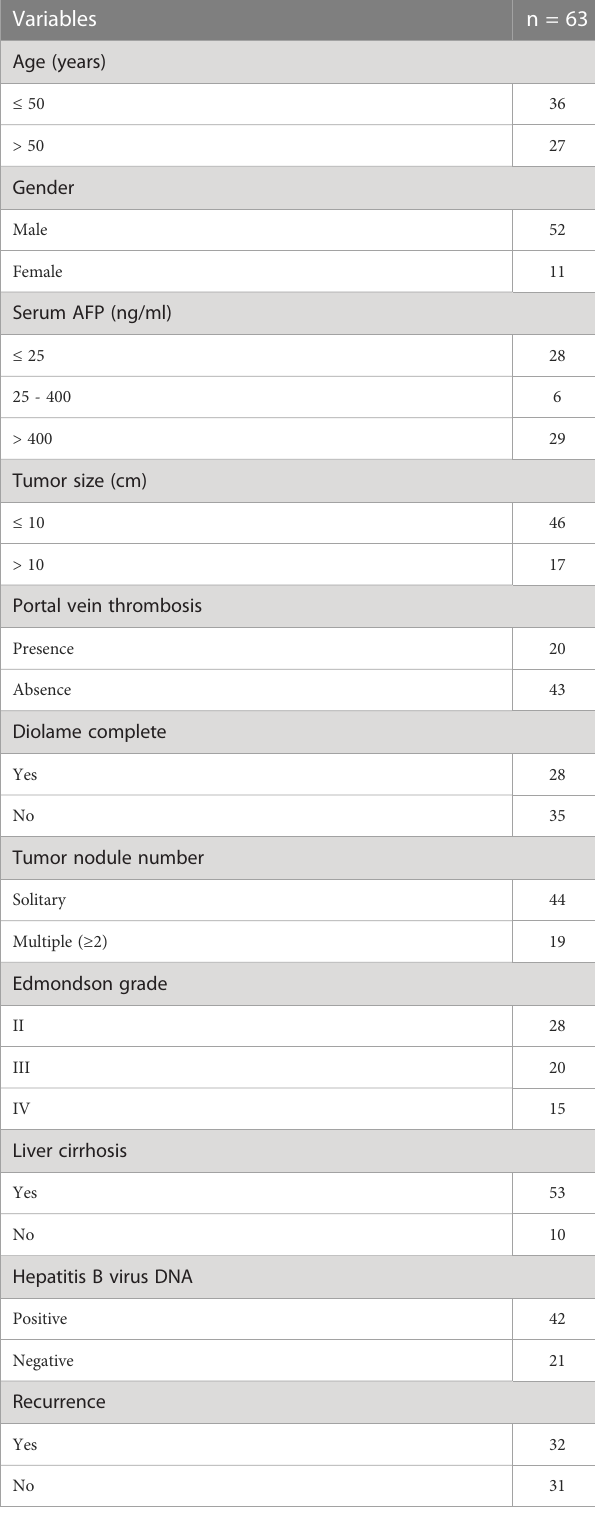
TABLE 1 Clinicopathological variables of 63 patients with hepatocellular carcinoma (HCC).